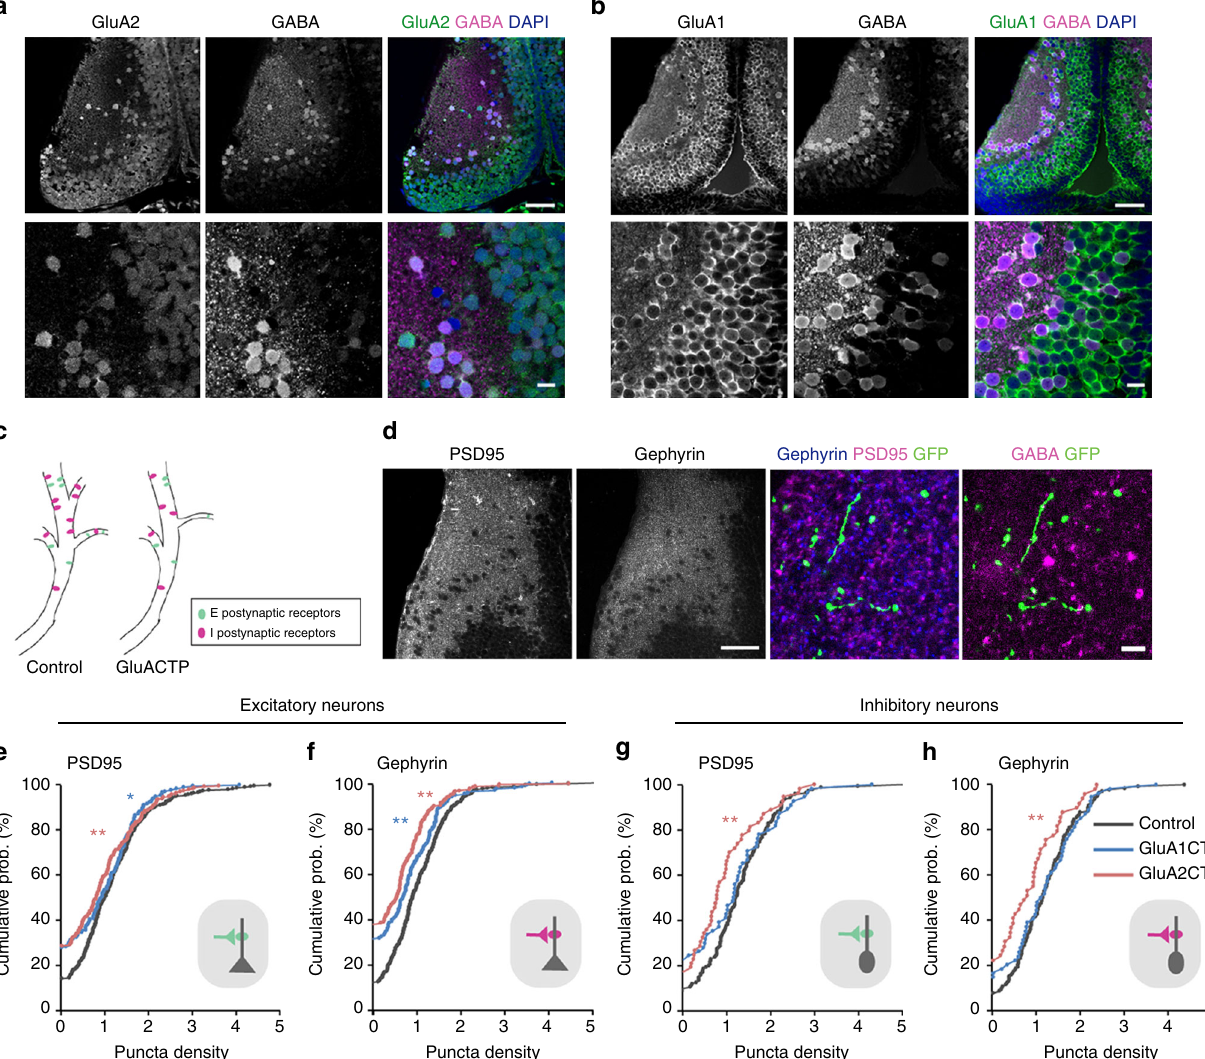
Fig. 2 Decreased excitatory inputs induced cell-autonomous decreases in inhibitory synaptic inputs in both excitatory and inhibitory neurons. a , b Co- immunolabeling of GABA and GluA2 ( a ) or GluA1 ( b ) antibodies shows that both GluA1 and GluA2 are widely expressed in the tectum and are found in both excitatory (GABA-negative) and inhibitory (GABA-positive) neurons. Scale bar: top: 50 μ m; bottom: 10 μ m. c Schematic illustrates excitatory and inhibitory synapses on excitatory and inhibitory postsynaptic neurons. d PSD95 and gephyrin immunolabeling in the tectum (left) show high puncta density in the neuropil and relatively low density in the somatic region. Right: representative images of PSD95 and gephyrin puncta in a GFP + dendritic segment. The identity (excitatory or inhibitory) of the GFP + dendrite was determined by GABA immunolabeling. Scale bar: left: 50 μ m; right: 10 μ m. e - h Summary data showing GluA1CTP and GluA2CTP decreased both PSD95 ( e ) and gephyrin ( f ) puncta density in excitatory dendrites (number of dendritic segments: Control: n = 250; GluA1CTP: n = 170; GluA2CTP: n = 210). In inhibitory dendrites, GluA2CTP, but not GluA1CTP, signi fi cantly decreased PSD95 ( g ) and gephyrin ( h ) puncta density (number of dendritic segments: Control: n = 134; GluA1CTP: n = 54; GluA2CTP: n = 49). * P < 0.05; ** P < 0.01; Kruskal –